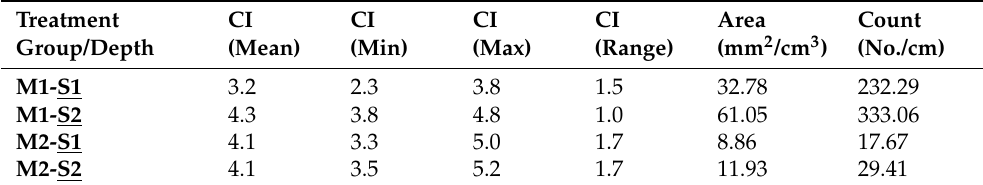
Table 5. Summary of average values of M1 and M2 treatment groups in the upper core (S1) and lower core (S2). Minimum, maximum, and range of CI and charcoal influx area (mm 2 /cm 3 ) and count (No./cm 3 ) across sections S1 and S2 are